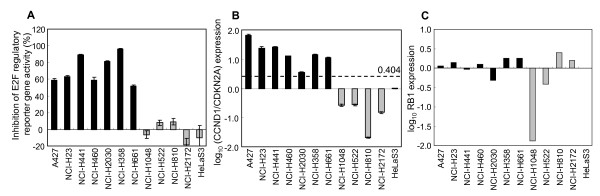
CCND1/CDKN2A expression predicts RB1 status. (A) RB1 status of 12 cell lines determined by RB1 functional assay. Each cell line was transfected with E2F-regulatory reporter SEAP plasmid with or without the CDKN2A expression vector. The inhibition level of the SEAP reporter gene activity in response to CDKN2A induction was normalized to luciferase activity. (B) RB1 status of 12 cell lines predicted by the expression ratio of CCND1/CDKN2A. mRNAs from the 12 cell lines were analyzed with quantitative RT-PCR analysis for CCND1 and CDKN2A. The threshold of CCND1/CDKN2A to determine RB1 status was established as 0.404 by discriminate analysis. The RB1 statuses determined by CCND1/CDKN2A coincided with those determined by RB1 function assay. (C) Relative RB1 mRNA expression level in 12 cell lines measured with quantitative RT-PCR assay.